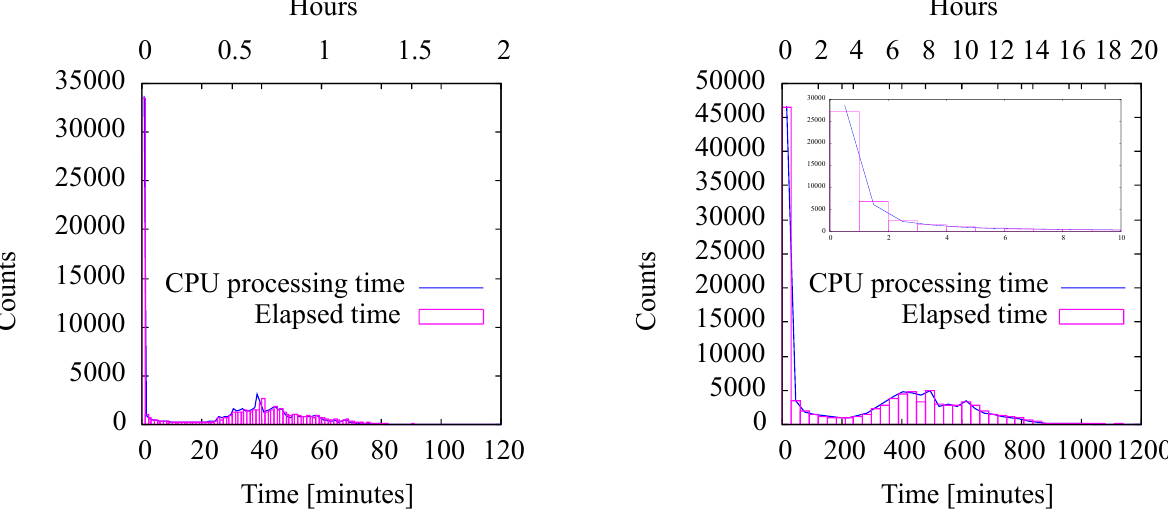
Figure 8: Distribution of the processing time of SixTrack runs on volunteers’ computers. The bin width is 1 minute for the 10 5 turn runs (left panel) and 30 minutes for the 10 6 turn runs (right panel). The inset shows the distribution of the first 10 minutes using a 1 minute bin. Table 1: Statistical distribution of different category computational results for a 7 -day time